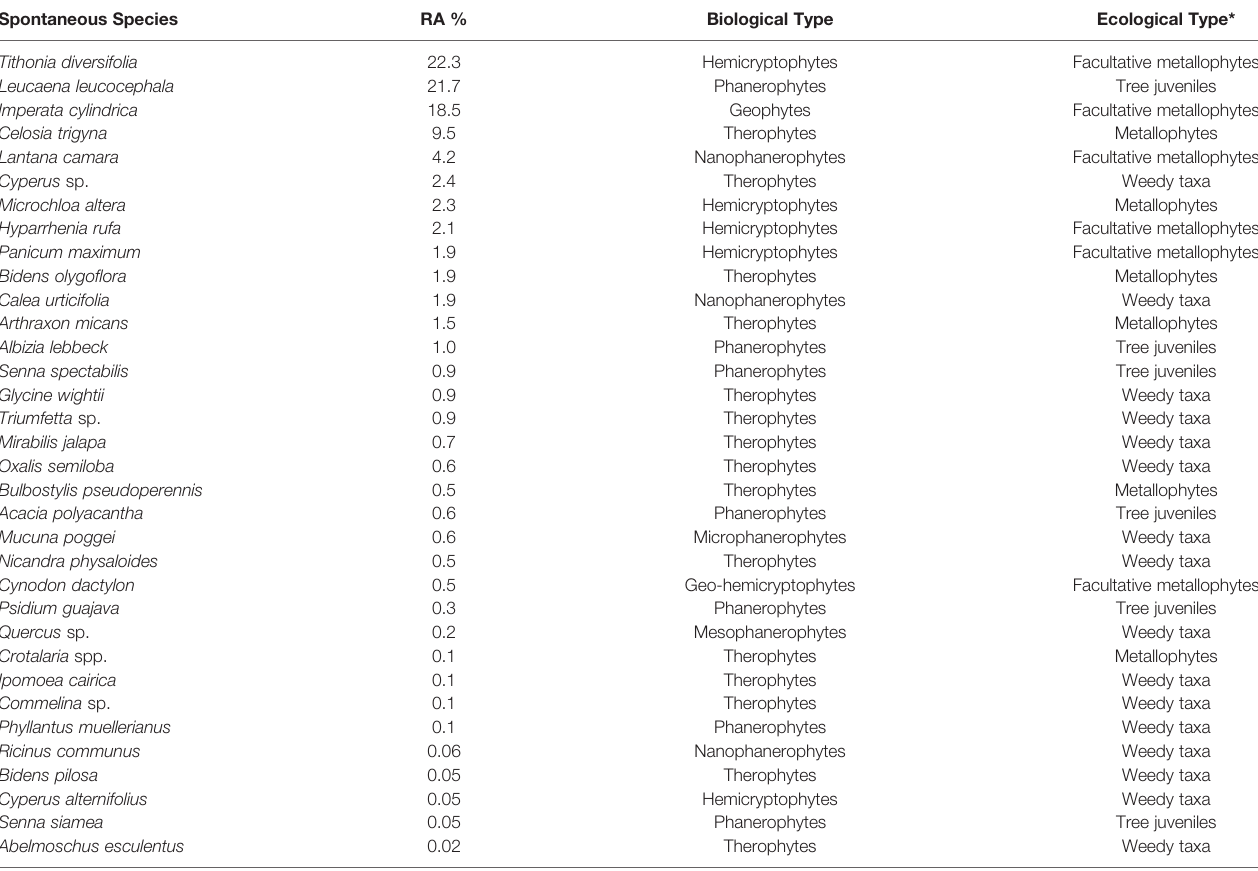
TABLE 3 | Spontaneous vegetation around main tree species (64 quadrats of 9 m 2 around trees in the plantation of 15,000 m 2 ; RA, relative abundance). Spontaneous